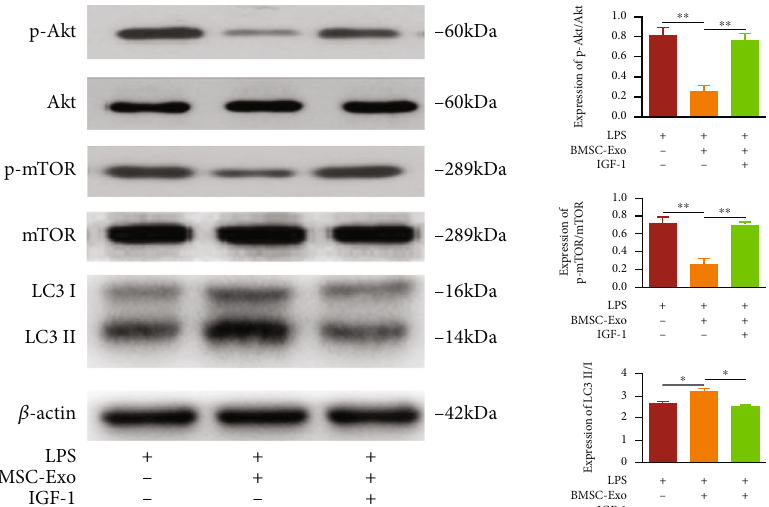
Figure 3: Western blot detects the relative expression changes of p-Akt, Akt, p-mTOR, mTOR, and LC3 in each group. n = 6 . ∗ P < 0 : 05 ; ∗∗ P < 0 : 01